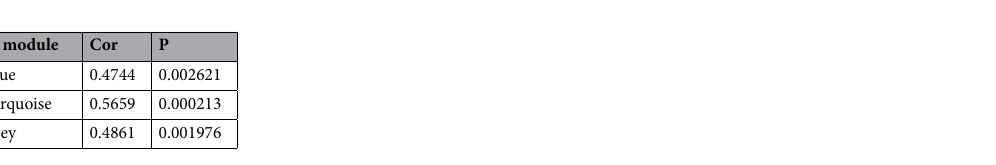
Table 2. The Pearson Correlation and P-values between gene modules and IDD.